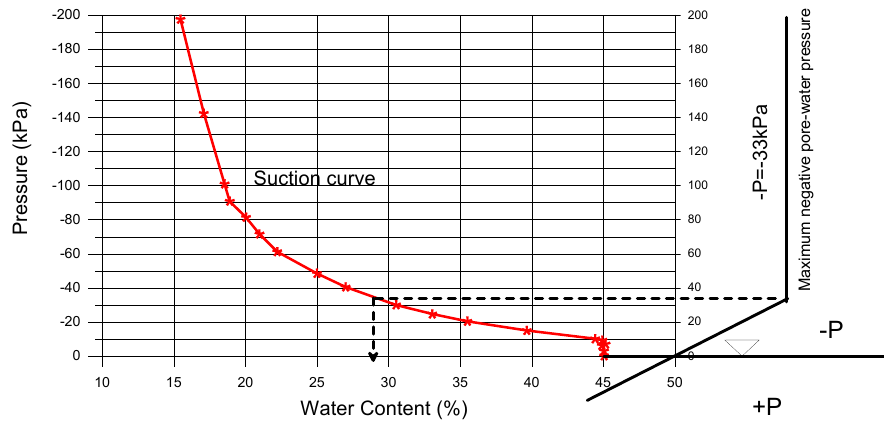
Figure 6. Daily river water level (RWL) and daily rainfall from 1 July to 31 August 2016.